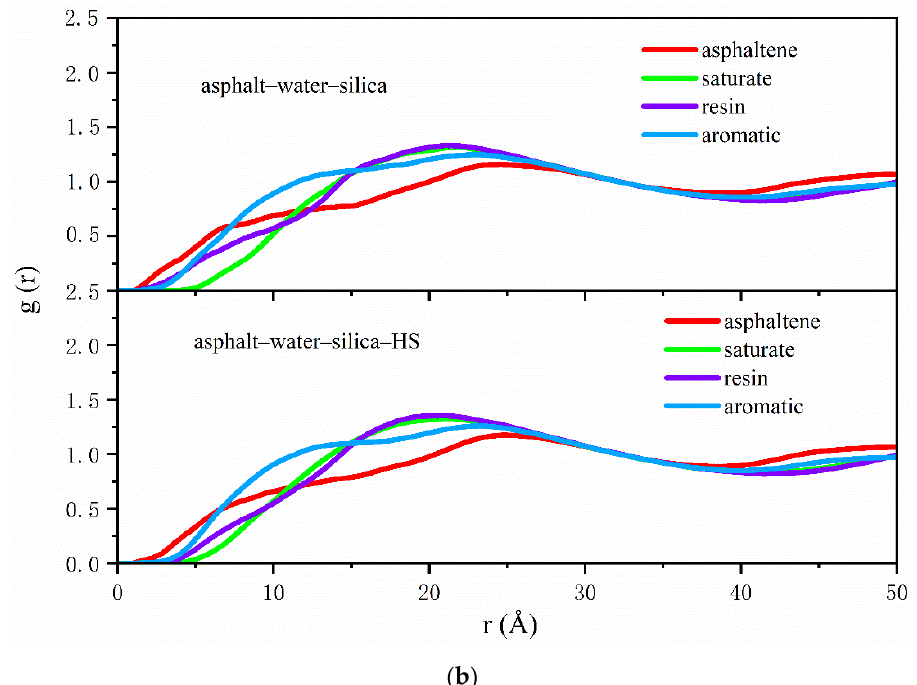
Figure 7. Asphalt–aggregate interface RDF curves under wet conditions with and without adsorbed water on the aggregate surface: ( a ) asphalt–water–calcite and ( b ) asphalt–water–silica.